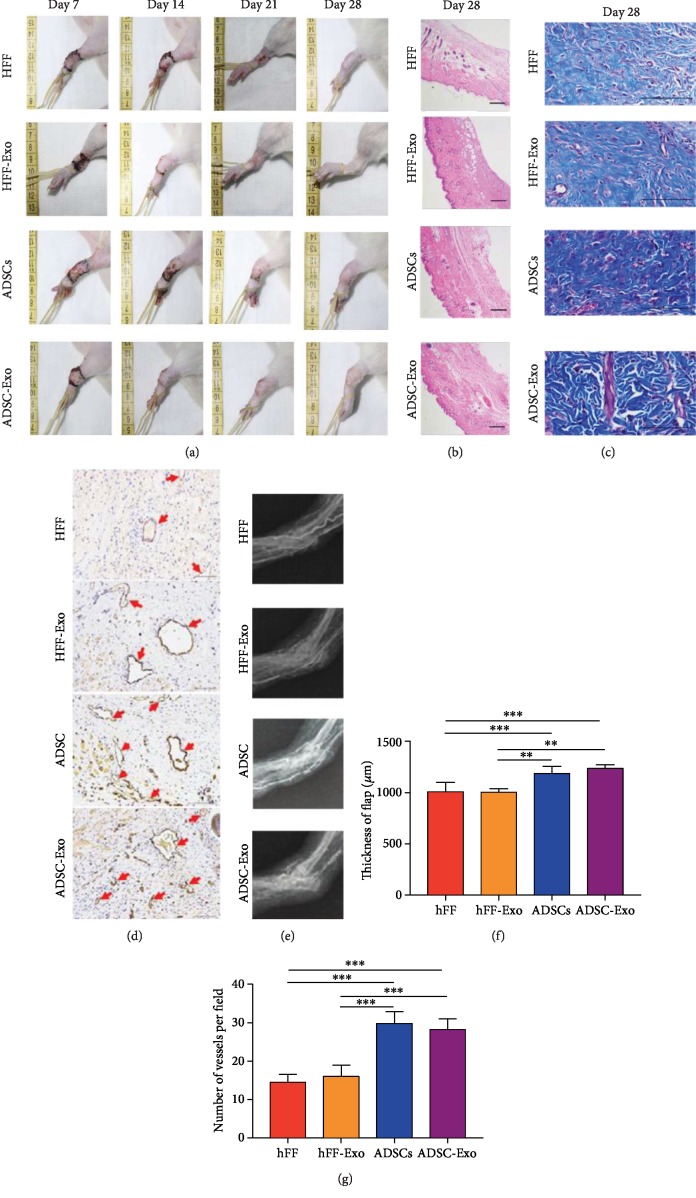
ADSC-Exo promotes repair and vascularization of prefabricated flap graft wounds in vivo. (a) The repair process of prefabricated skin flaps in rats of each group. (b) Microscopic observation of the section showing the flap thickness in four groups. Scale bare = 200 μm. (c) Masson staining for mature collagen. Scale bare = 100 μm. (d) Microscopic observation of CD31 immunostaining. Brown reaction products means CD31-positive immunohistochemical staining and red arrow indicates mature blood vessels. Scale bare = 100 μm. (e) The microvascular angiography of each group. (f) Quantitative analysis of the flap thickness in each group. (g) Quantitative analysis of the number of mature blood vessels. ∗∗P < 0.01 and ∗∗∗P < 0.001.